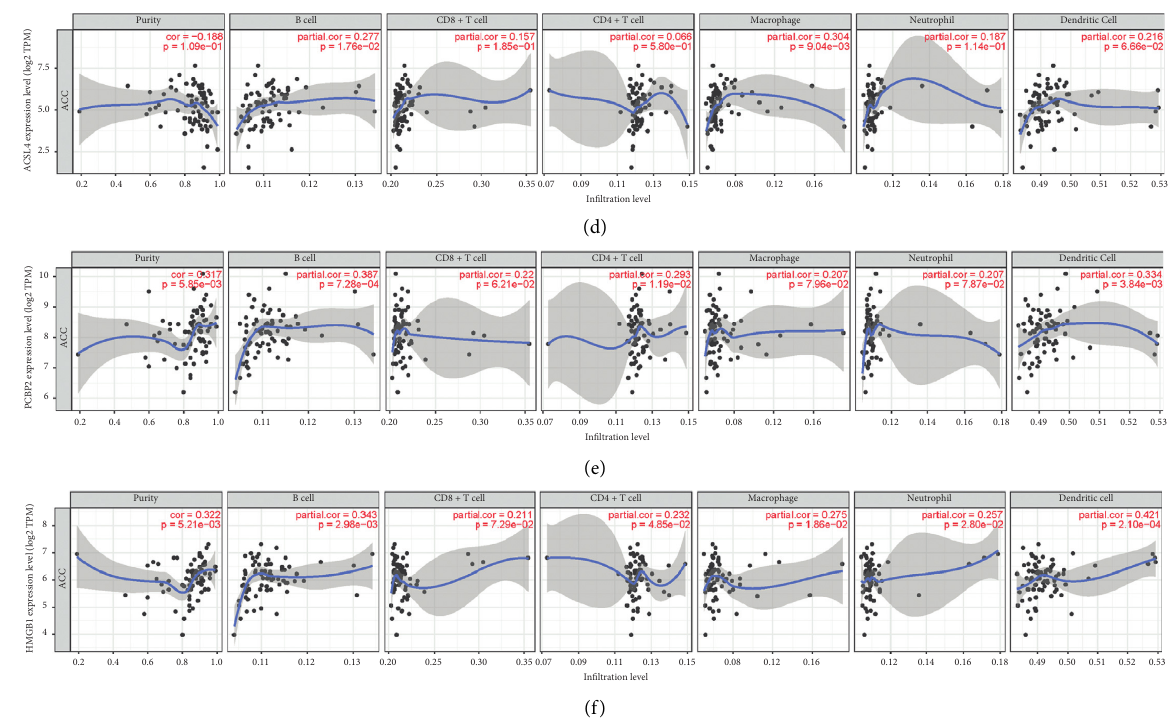
Figure 6: Relationships between the ferroptosis-associated genes and immune infiltration. (a–f). Relationship between the 6 hub fer- roptosis-associated genes expression (SLC7A11, TP53, HELLS, ACSL4, PCBP2, and HMGB1) and the infiltrating levels of six immune cells in